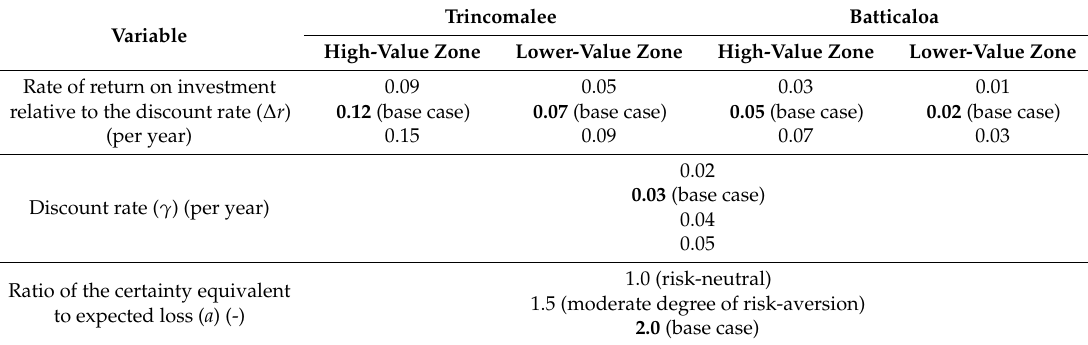
Table 3. The inputs of the sensitivity analyses related to the economic